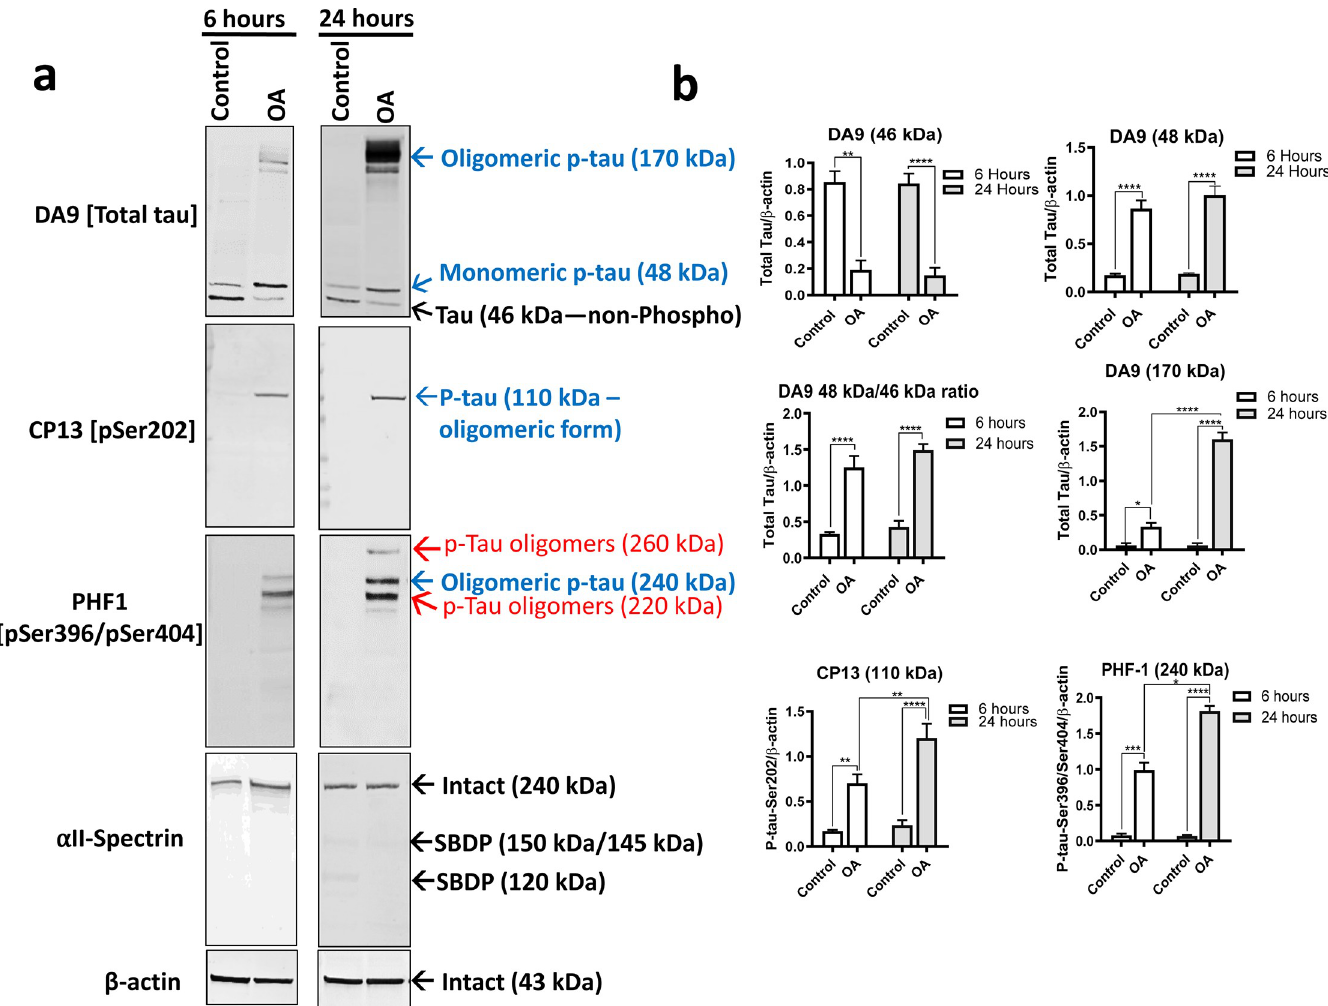
Fig 1. OA induced tau hyperphosphorylation and oligomerization at different time points in mouse neuroblastoma N2a cells. (a). Immunoblots of N2a cells extracted protein (20 μ g) using total and phospho-tau antibodies: DA9 (a.a. 102–140), CP13 (pSer202), and PHF-1 (pSer396/pSer404). α II-Spectrin antibody was used to assess neuronal apoptotic pathway activation through monitoring intact spectrin (240 kDa), SBDP150/145 (calpain activation), and SBDP120 (caspase-3 activation). Different tau species are pointed with colored arrows. Blue arrows present monomeric p-tau (48 kDa), and oligomeric p-tau (110 kDa, 170 kDa, and 240 kDa). Red arrows on PHF-1 points on two minor bands of oligomeric p-tau (220 kDa and 260 kDa). Black arrows show non-phospho tau band (46 kDa). SNJ-1945 (abbreviated as S; a calpain inhibitor, 100 μ M) and Z-DCB (abbreviated as Z; a caspase-3 inhibitor, 60 μ M) were added for all experimental conditions for 1h before the treatment with OA (100 nM) for 6h or 24h, to prevent apoptosis-mediated proteolysis of tau and α II-Spectrin. A reverse-time course followed OA treatment, and all cells were collected at the same time and conditions. (b). Immunoblots quantification. All data are normalized to β -actin and are expressed as a percentage of control. Data are presented as ± SEM for n = 3. Statistical analysis was performed with one-way ANOVA. For multiple comparisons, one-way ANOVA followed by Bonferroni’s post-hoc test was performed. � p < 0.05, �� p < 0.01, ��� p < 0.001, ���� p < 0.0001 and ns: